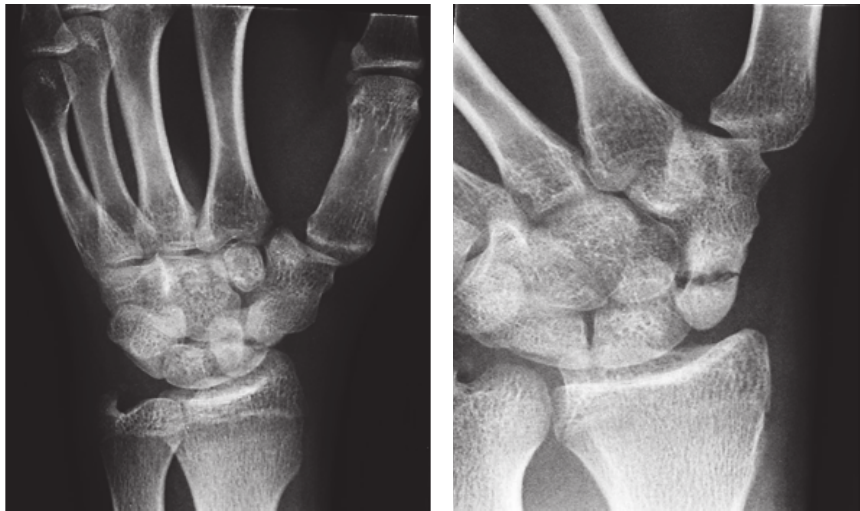
Figure 1: Radiographs show a displaced fracture through the waist of the scaphoid with Scaphotrapezial synostosis.